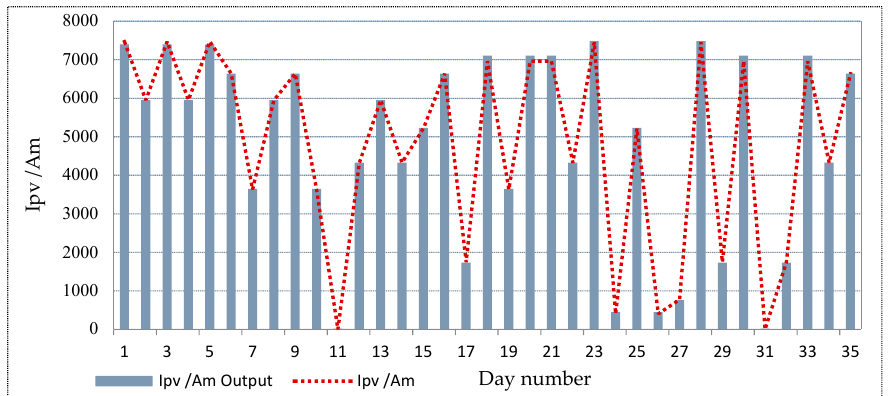
Figure 8. The testing results of the desired output and the proposed SOFM model output using 1000 epochs.